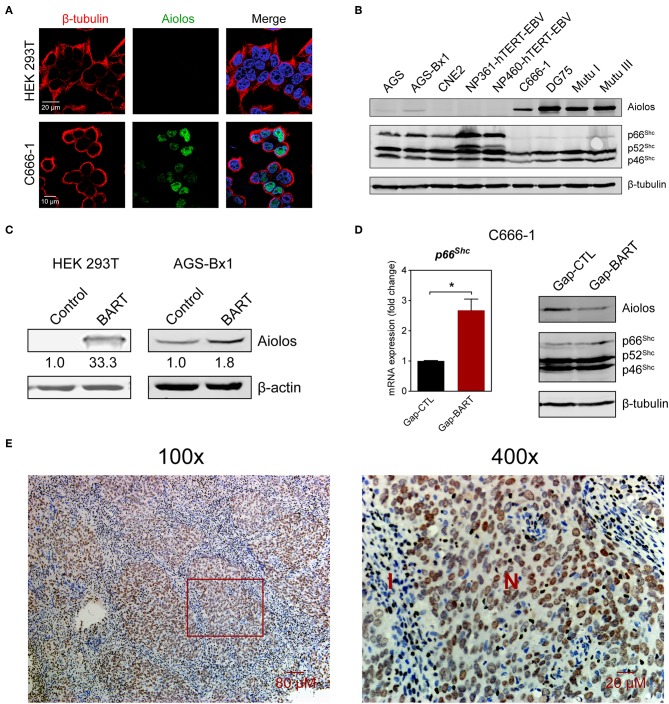
Aiolos expression in NPC. (A) Aiolos protein expression was analyzed by indirect immunofluorescence in HEK 293T and C666-1 cells. (B) Immunoblot analysis showing Aiolos and p66Shc expression in various cell lines. AGS, AGS-Bx1, CNE2, NP361-hTERT-EBV, NP460-hTERT-EBV, and C666-1 are epithelial cell lines, while DG75, Mutu I, and Mutu III are Burkitt's lymphoma cell lines. All cell lines are EBV-positive, except for AGS, CNE2, and DG75. (C) Effect of BART lncRNA on Aiolos expression. A plasmid containing one of the major species of BART lncRNAs (RPMS1) was transfected into HEK 293T and AGS-Bx1 cells. (D) Effect of targeting BART lncRNA with GapmeRs on levels of p66Shc mRNA expression and Aiolos protein expression. The average and SEM of three independent experiments are shown. Gene expression is shown as fold change in mRNA expression relative to that of GAPDH. *P < 0.05. (E) Immunohistochemistry for Aiolos was performed on 26 NPC biopsies. A representative image shows Aiolos staining (brown) in NPC cells at 100× and 400× magnification. I, cellular infiltrate; N, NPC cells.